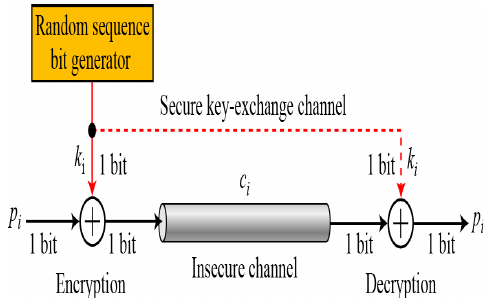
Fig. 1. Stream Cipher System